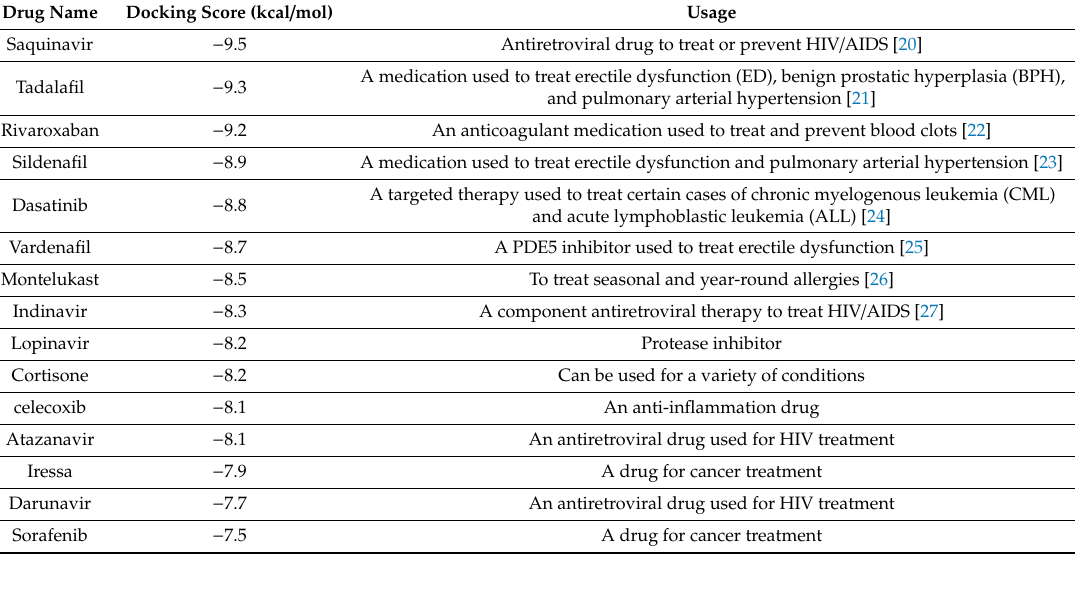
Table 1. Di ff erent docking scores (binding a ffi nities) of the tested drugs for SARS-CoV-2 proteinase.